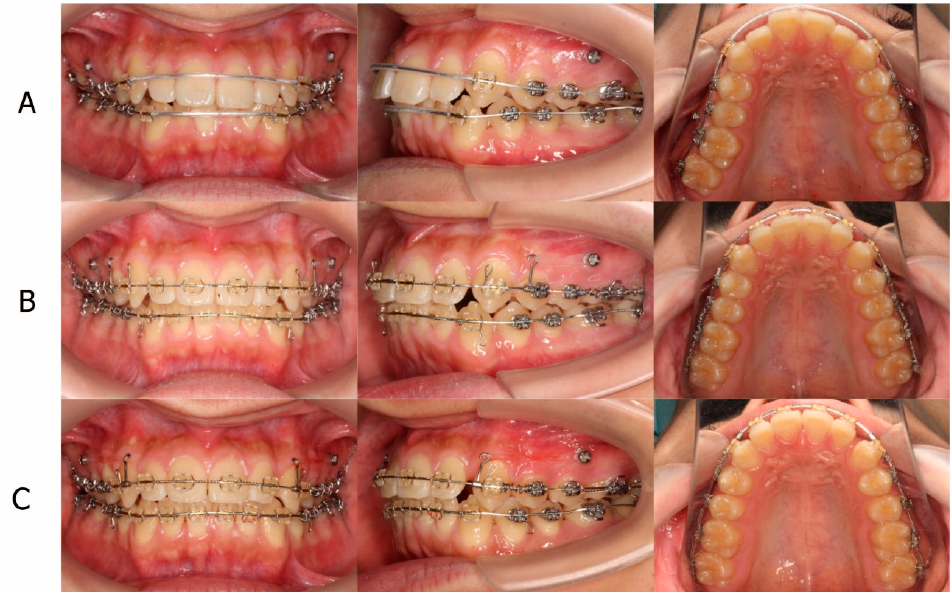
Figure 5. Progressive intraoral photographs. ( A ) Leveling of maxillary and mandibular lateral teeth; ( B ) distalization of the maxillary molars and uprighting of the mandibular molars; ( C ) distalization of the maxillary canines and premolars.